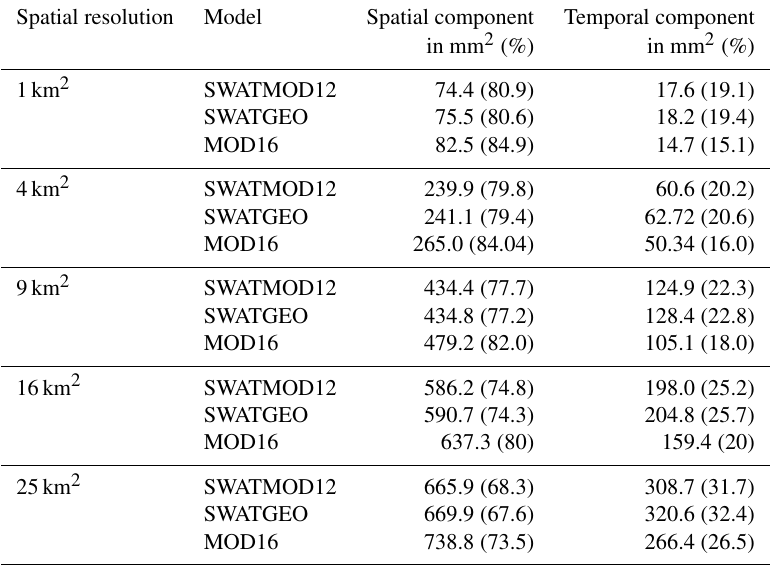
Table 5. Variance partitioning into space and time components at various spatial